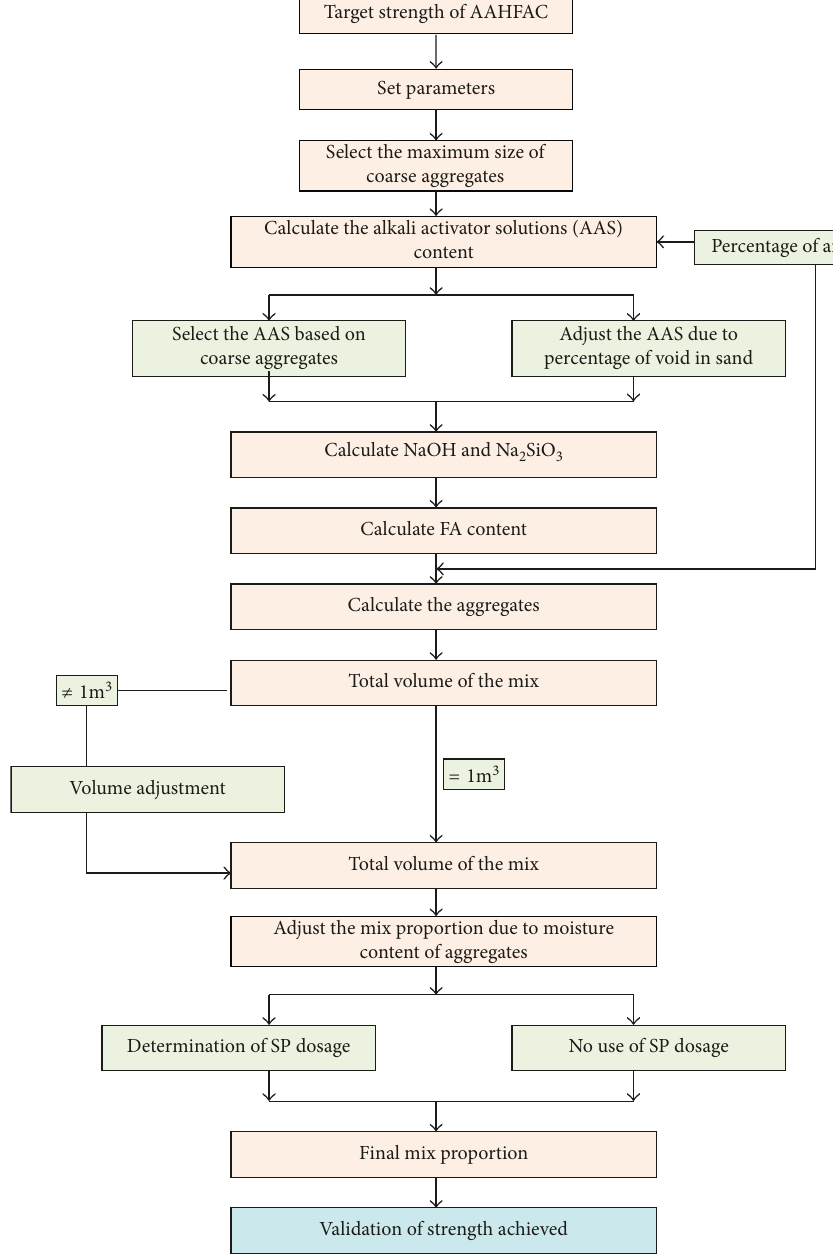
Figure 1: Flow chart for the mix design